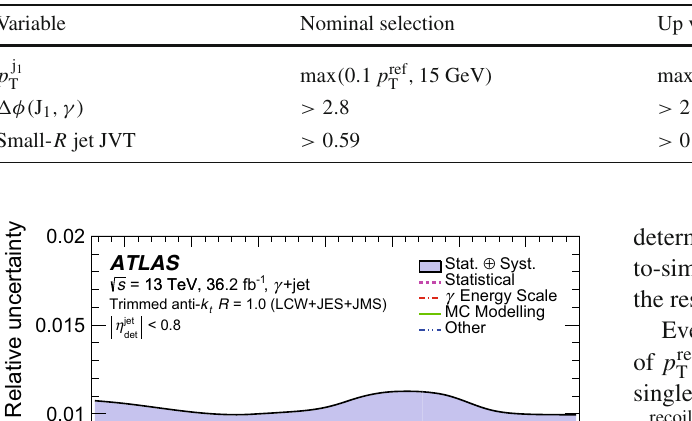
Table 3 Summary of the selection and systematic variations considered for the γ +jet direct balance analysis. The labels J 1 refers to the leading large- R jet and j 1 to the leading small- R jet that fulfils (cid:4) R ( J 1 , j ) > 1 . 4